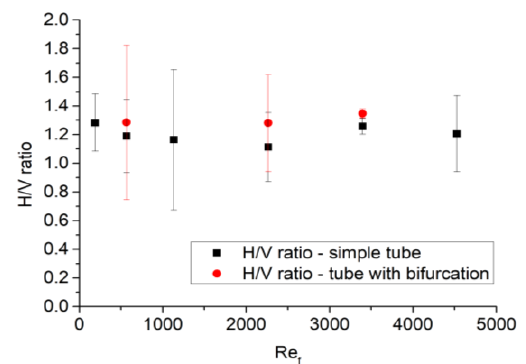
Figure 2. The ratio of horizontally and vertically oriented fibres as a function of the flow Reynolds number. The error bars show standard